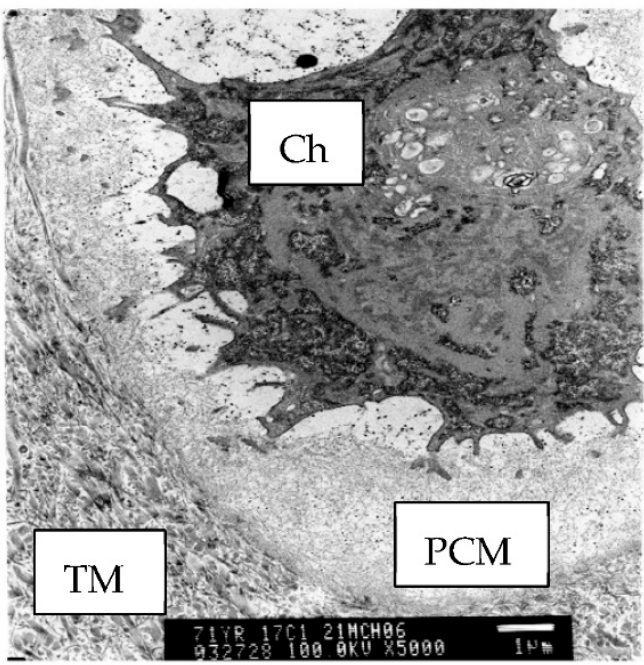
Figure 1. Electron micrograph of human articular cartilage showing a single chondrocyte (Ch) sitting within its pericellular matrix (PCM) and embedded within the type II collagen-rich territorial matrix (TM). Scale bar 1 μ m.